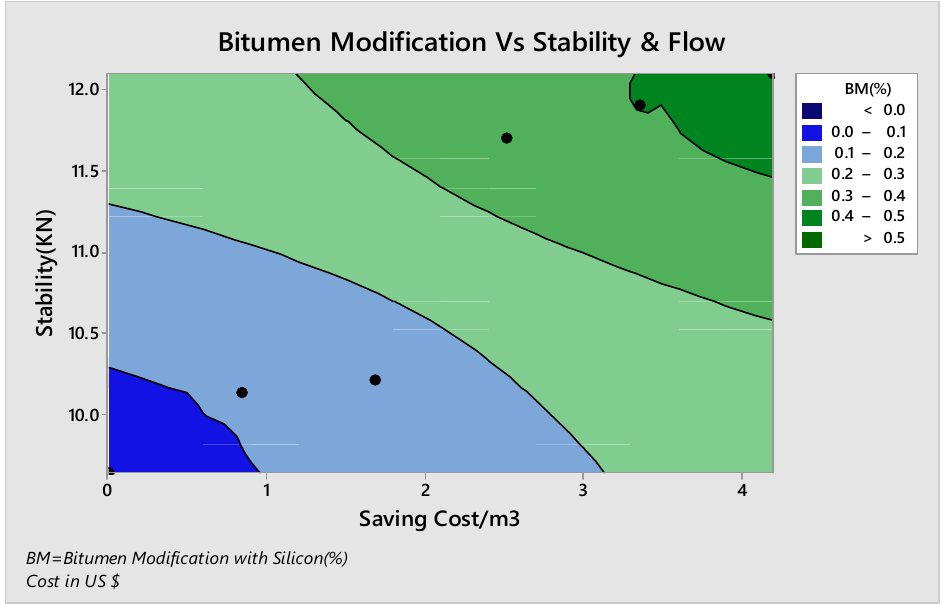
Figure 4. Comparative performance analysis of bitumen modification vs stability (KN) and saving ($) .